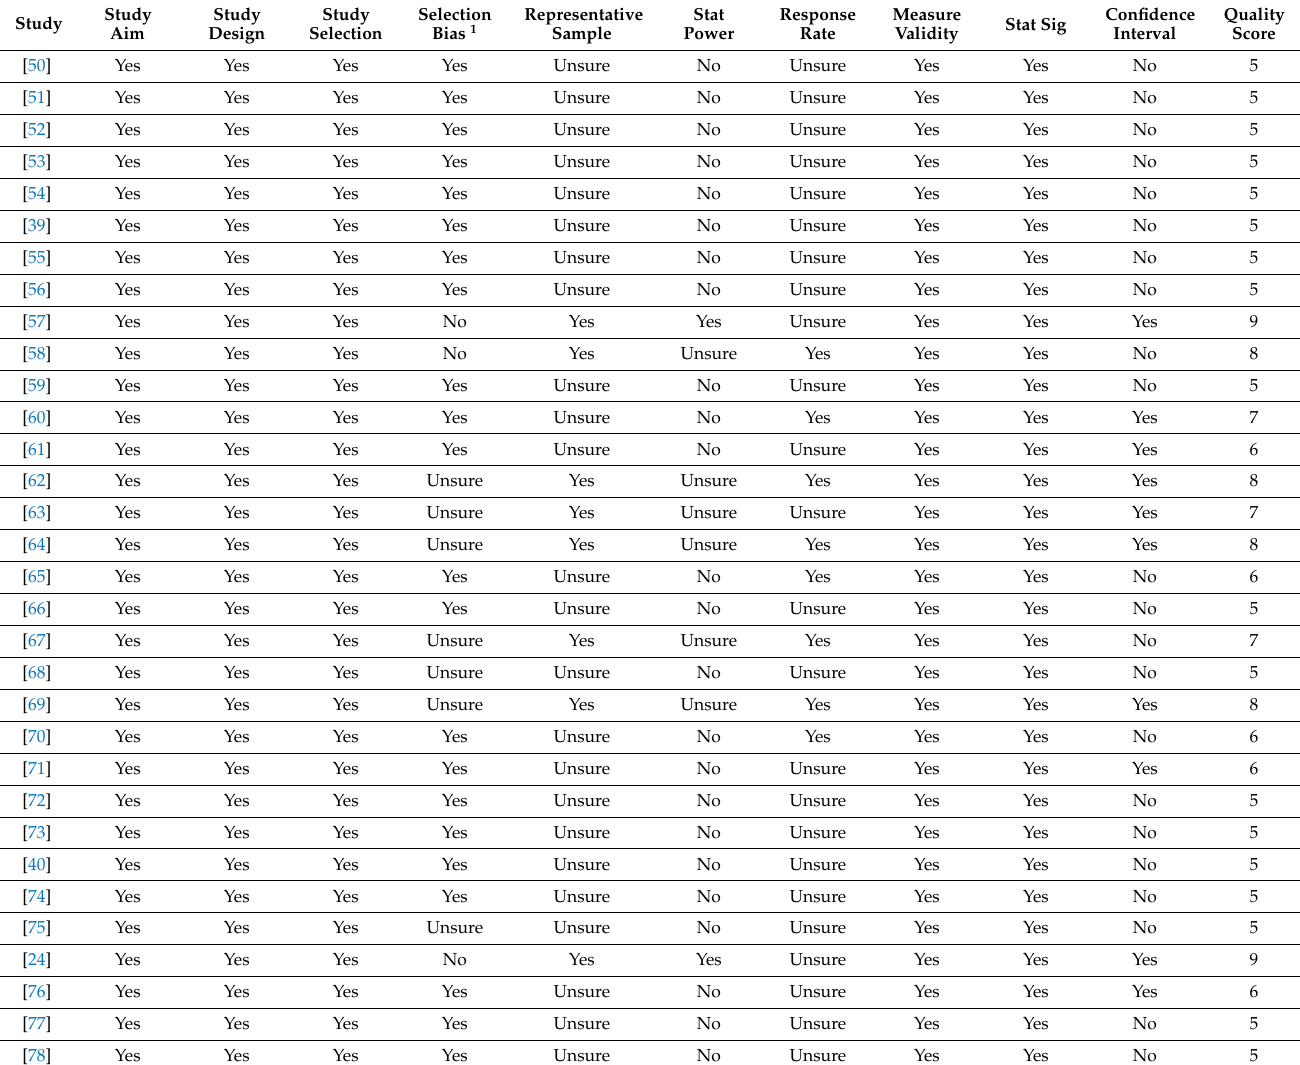
Table 3. Study rigour